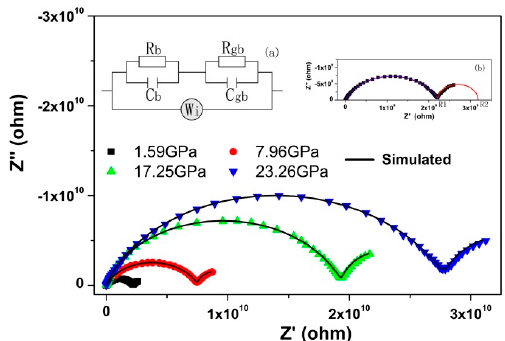
Figure 4. The Nyquist impedance spectra under several pressures. The inset ( a ) shows the equivalent circuit model, R b and R gb are grain and grain boundary resistance, C b and C gb are grain and grain boundary capacitance, and W i is the Warburg impedance. The inset ( b ) is the spectroscopy at 1.59 GPa, R 1 and R 2 are two intercepts on the real impedance axis.